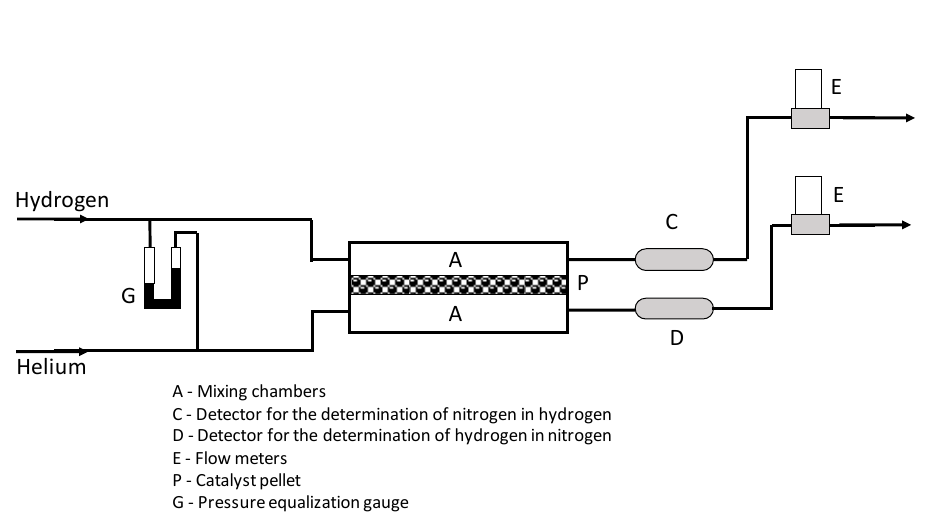
Figure 8. Scheme of the experimental device for the determination of effective diffusivity of a catalyst pellet.